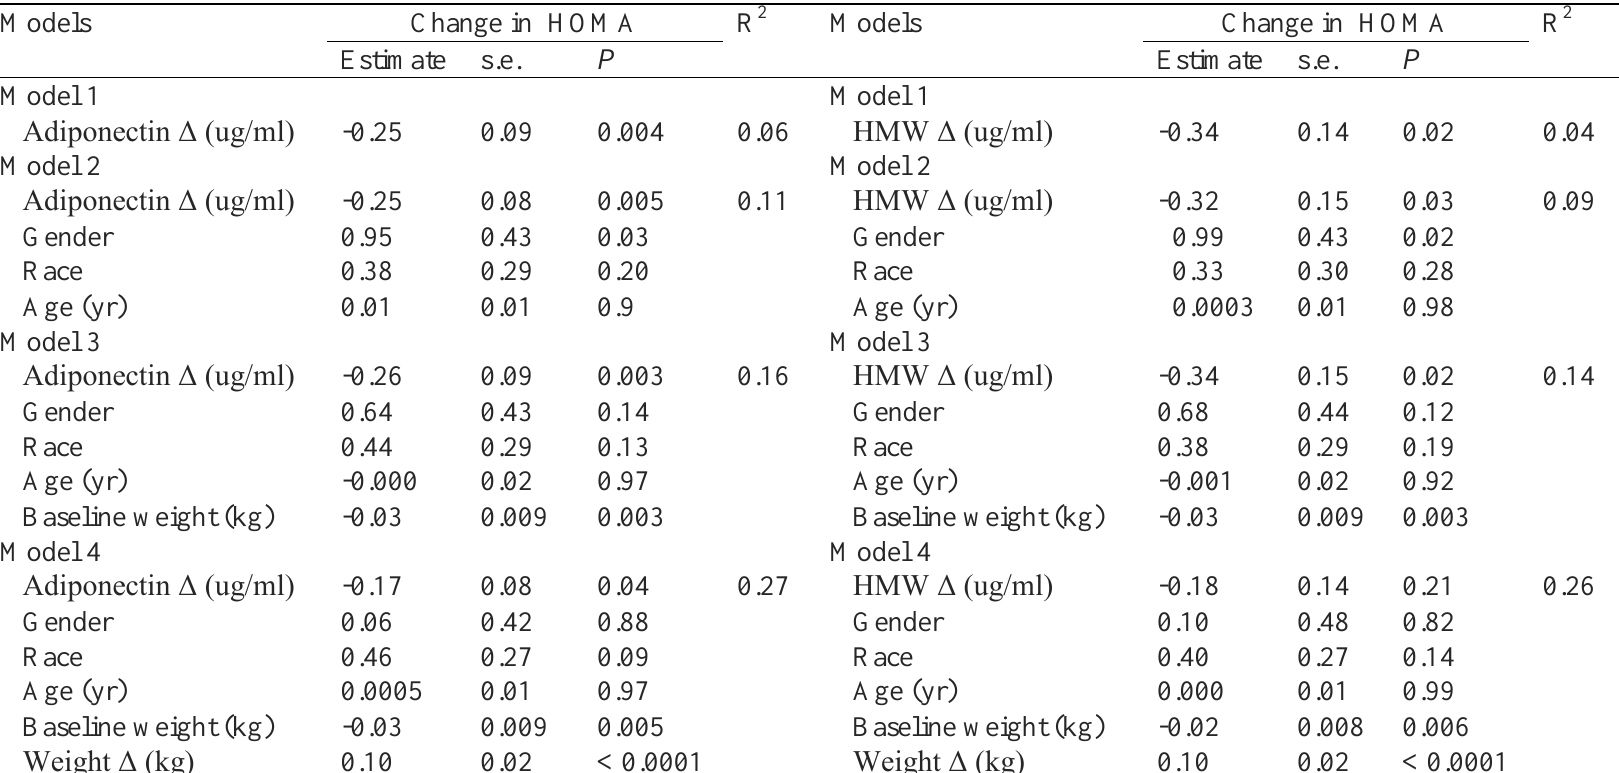
Table 3: Multiple regression models of total and HMW adiponectin levels on change in HOMA measure at 6 months (N =